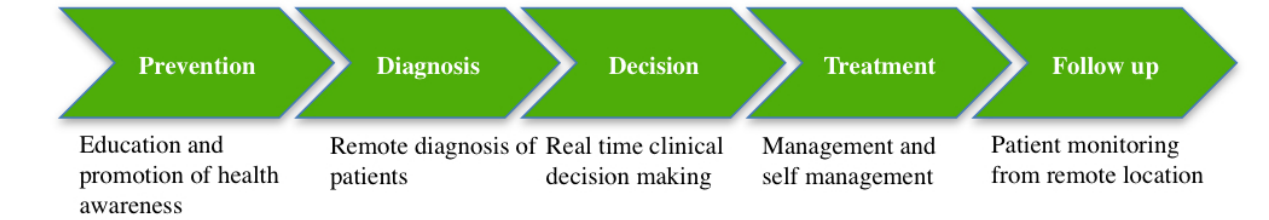
Figure 2. Mobile technologies in the health care